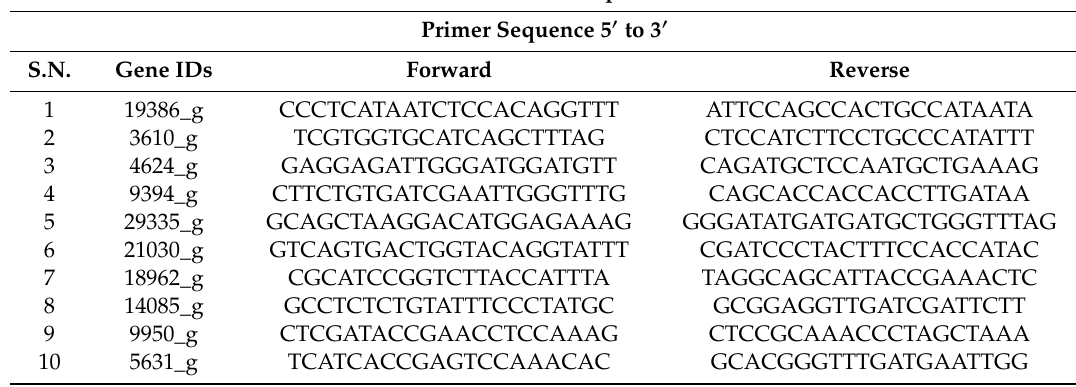
Table 1. List of primers used for qRT-PCR analysis for transcriptome data validation. Gene IDs are based on the annotation for an unpublished raspberry genome assembly (Lachesis_Heritage Version 1.1). Selected Primers Used for Transcriptome Data Validation